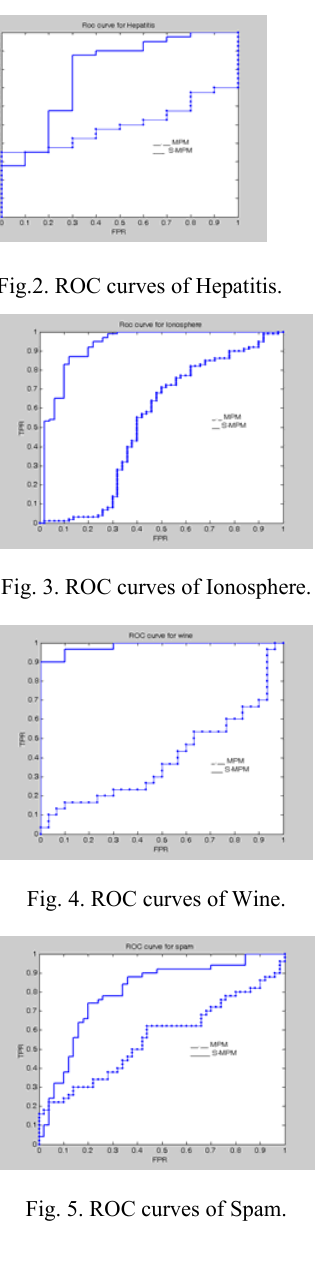
Fig. 6. ROC curves of German credit.